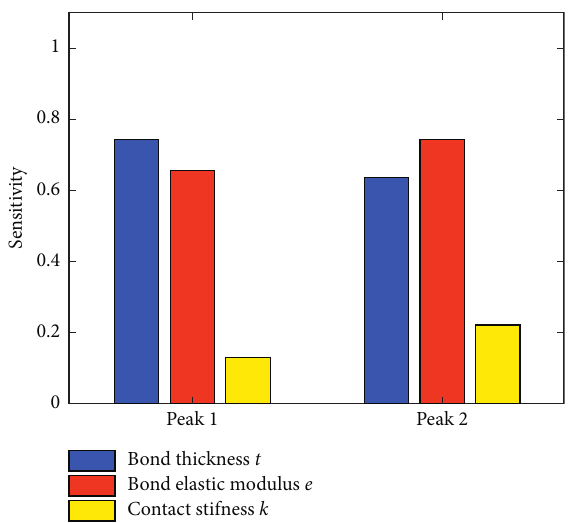
Figure 9: Modal sensitivities of the model-updating parameters.